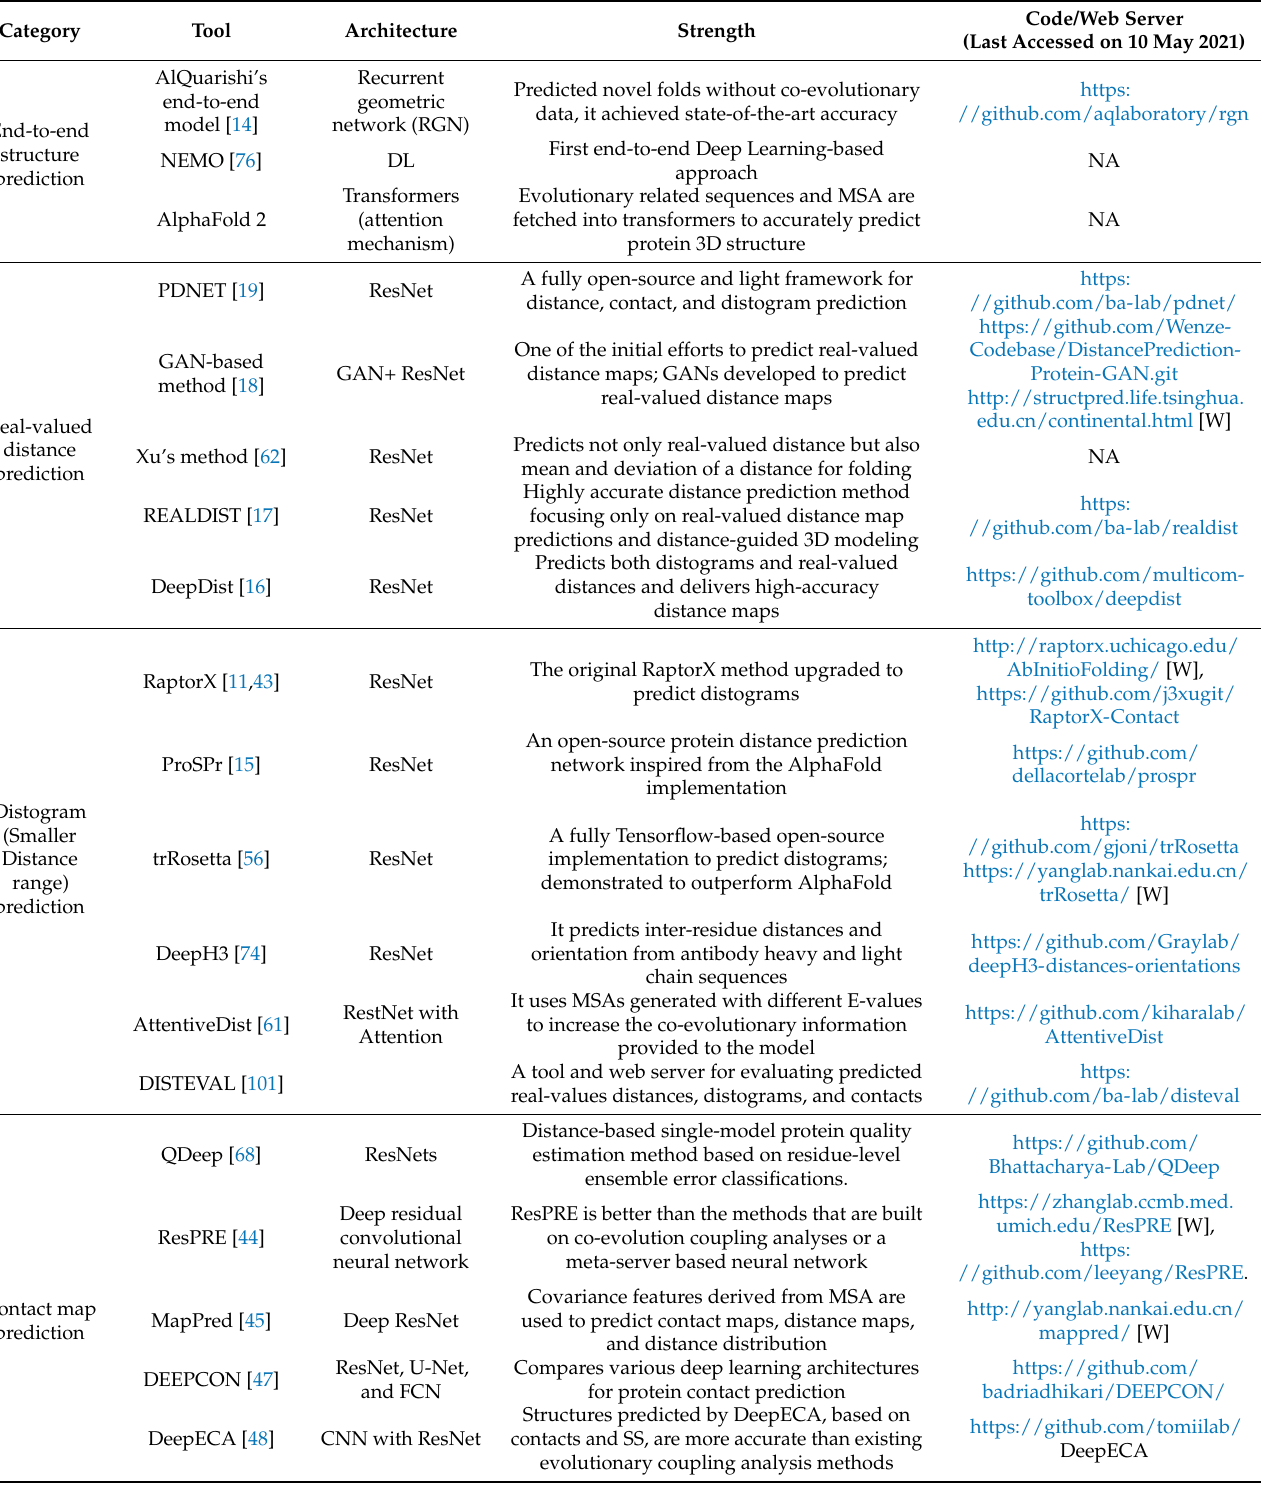
Table 1. Summary of tools: category, architecture, strength/uniqueness, and availability of the tools described in this article. Category Tool Architecture Strength